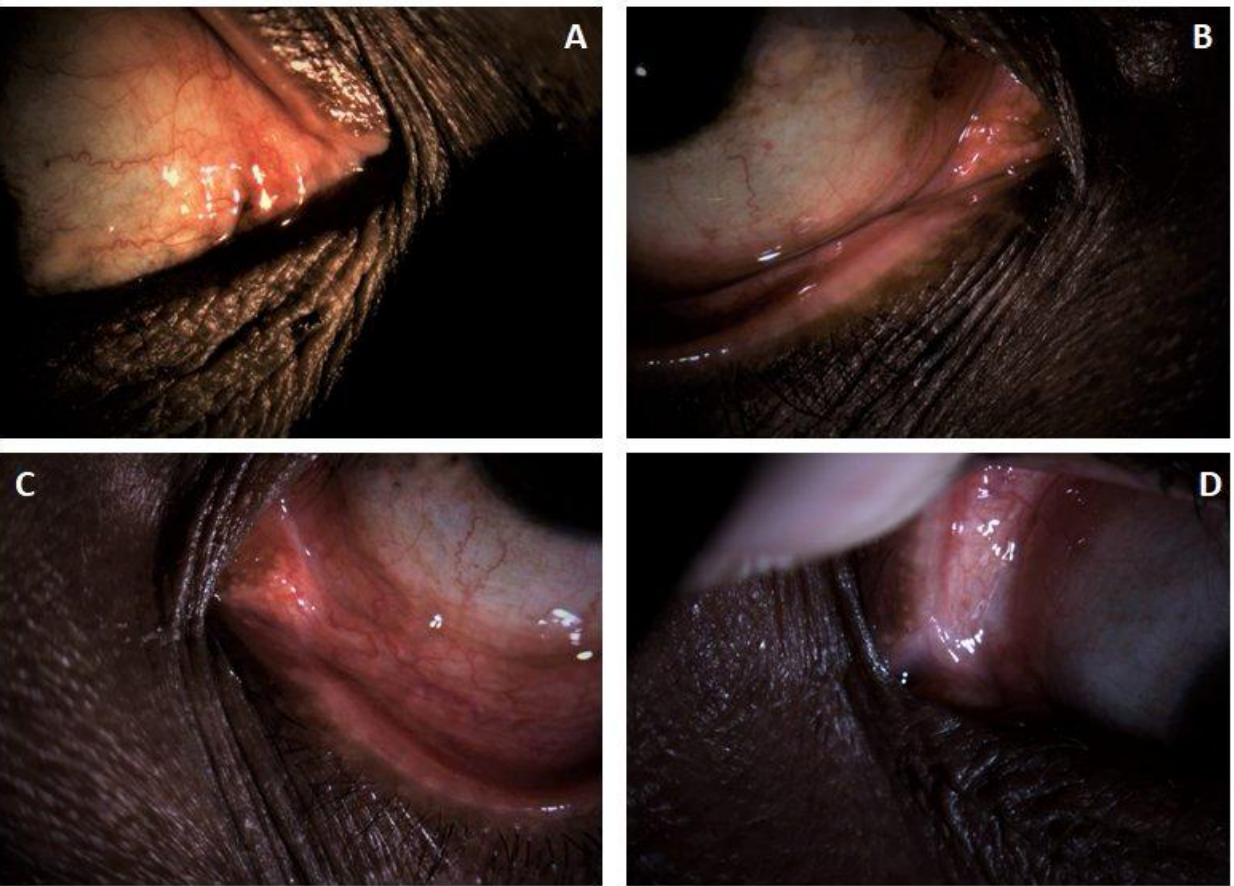
Figure 1 : Ocular examination revealed the absence of right upper (A), right lower (B) and left lower (C) punctum. Only left upper punctum (D) was